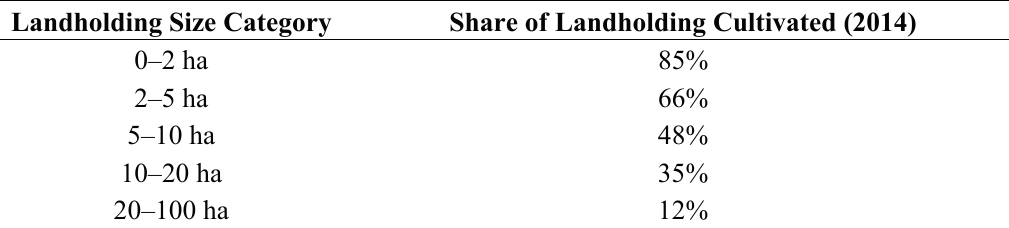
Table 5. Share of land cultivated by landholding size. Source: CFS 2014.